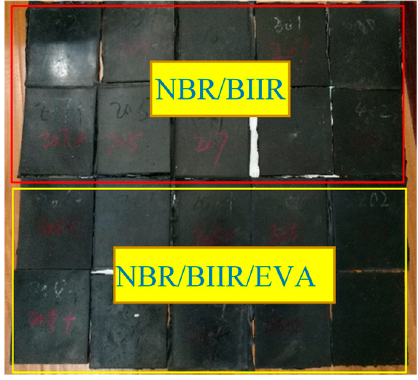
Figure 3. S amples after aging. Figure 3. Samples after